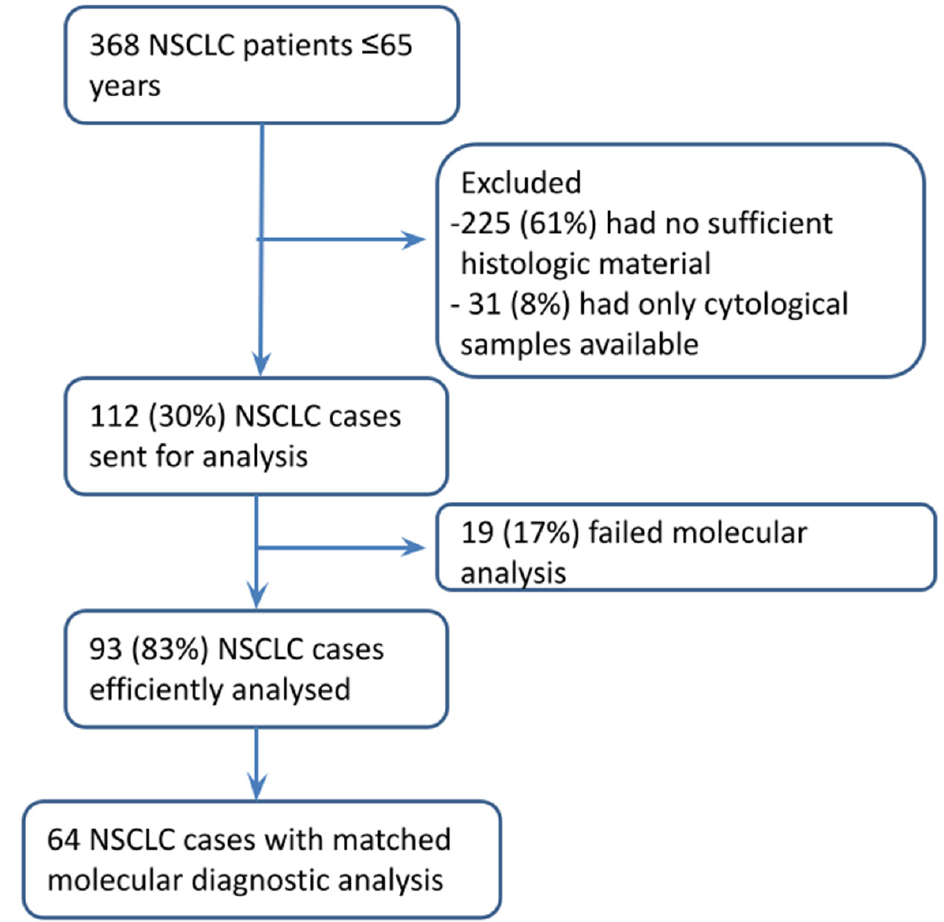
Figure 1. Flow chart of patient enrolment.